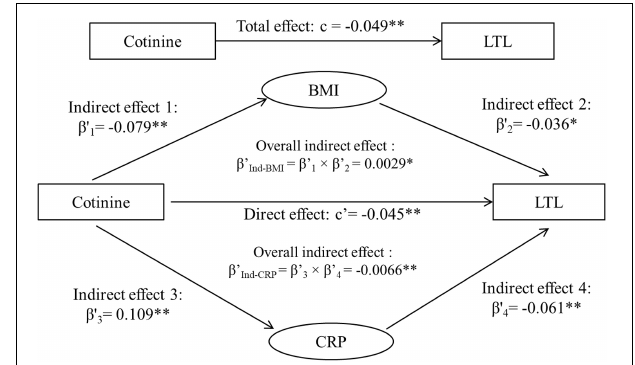
FIGURE 3 | Third variable model of serum cotinine, BMI, CRP and LTL, adjusting for age, race, sex, physical activity, and alcohol drinking. β ’, c, and c’ are standardized regression coefficients. c, total effect; c’, direct effect; β ’s, indirect effect; β ’ Ind , overall indirect effect; BMI, body mass index; CRP, C-reactive protein; LTL, leukocyte telomere length. ∗ p < 0.05 and ∗∗ p < 0.01 for β ’, c, and c’ being different from 0. Total effect (c), Direct effect (c’) + Indirect effect ( β ’ Ind − BMI ) + Indirect effect ( β ’ Ind − CRP ). − 0.0486 = − 0.0448 + 0.00285 + ( −